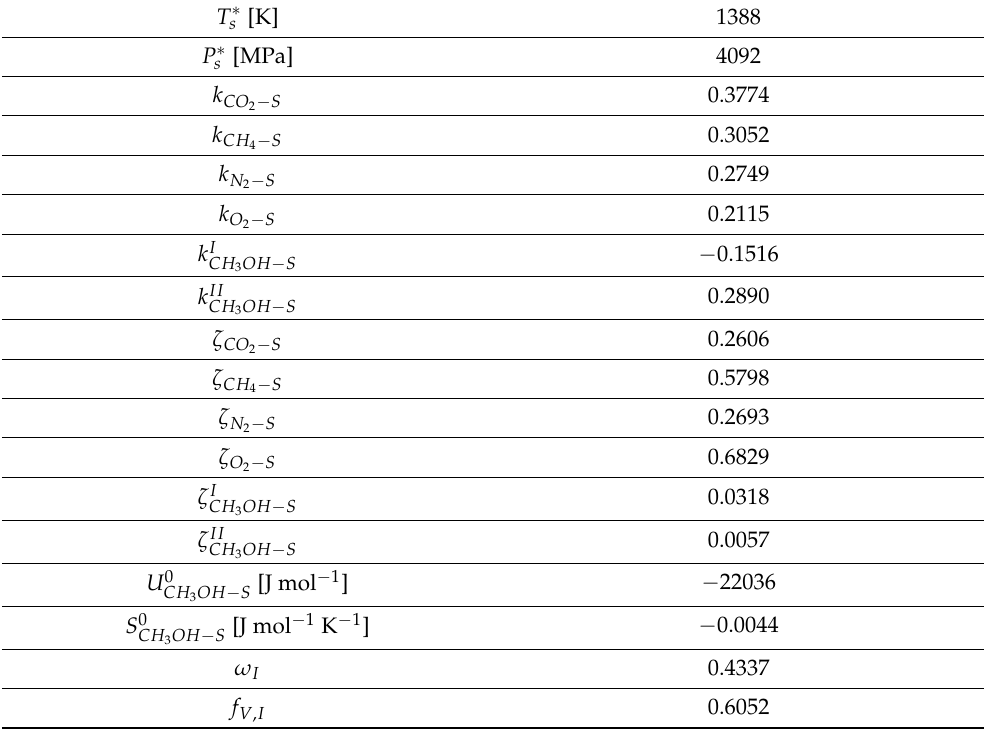
Table 4. Optimized values of fitting parameters of RALFHB